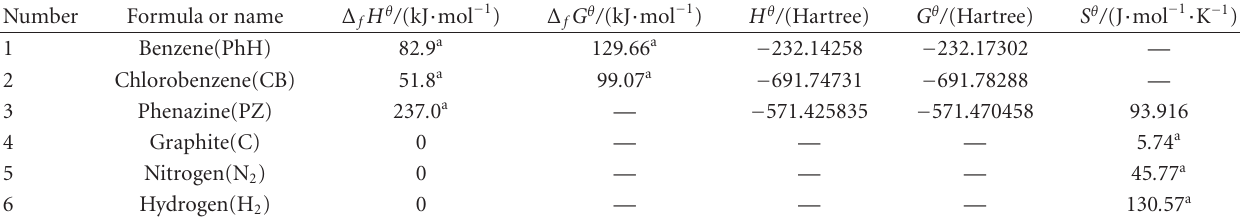
Table 1: Thermodynamic data used for calculating Δ f H θ and Δ f G θ of PCPZs.